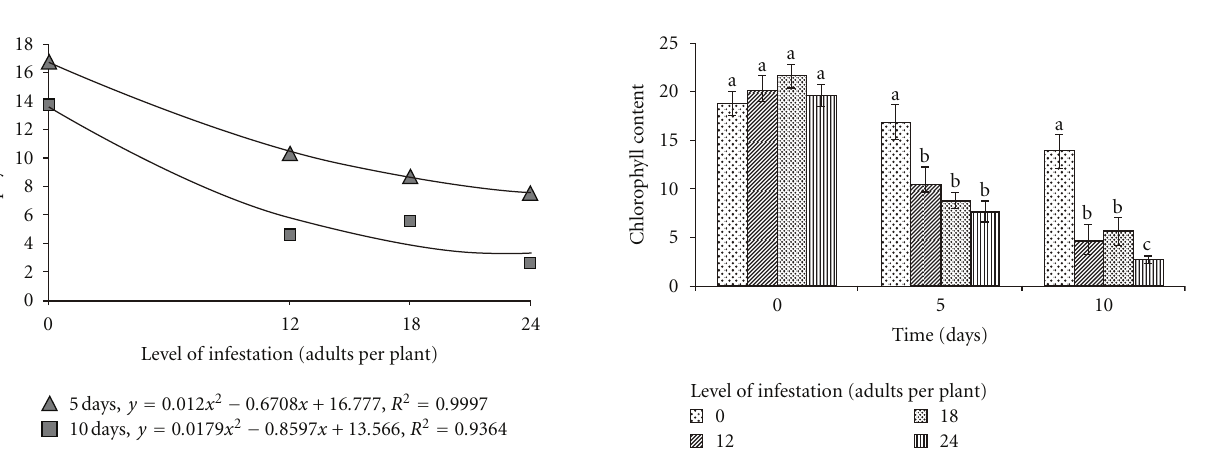
Figure 1: Relationship between infestation levels of adult M. spectabilis and chlorophyll content (SPAD unit) in B. ruziziensis over 5 or 10 days.